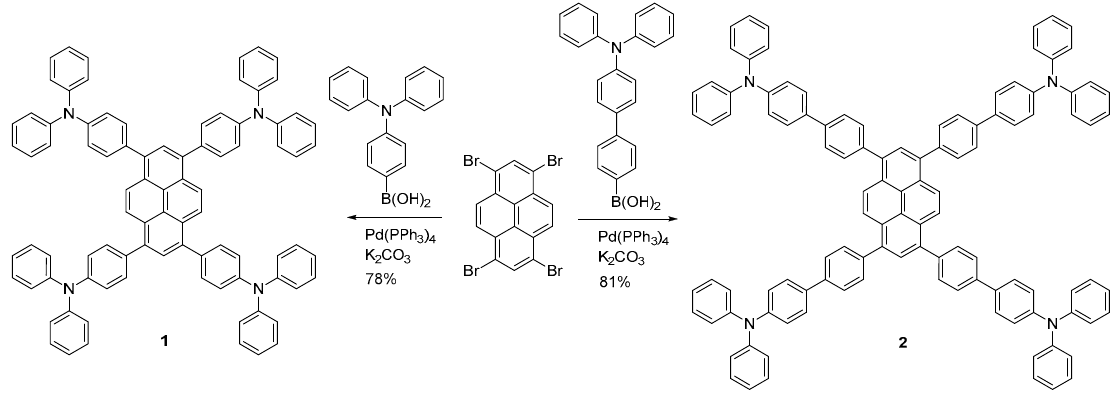
Figure 1. Schematic representation of the electropolymerization of triphenylamine monomers. R stands for any building block between two triphenylamine units.